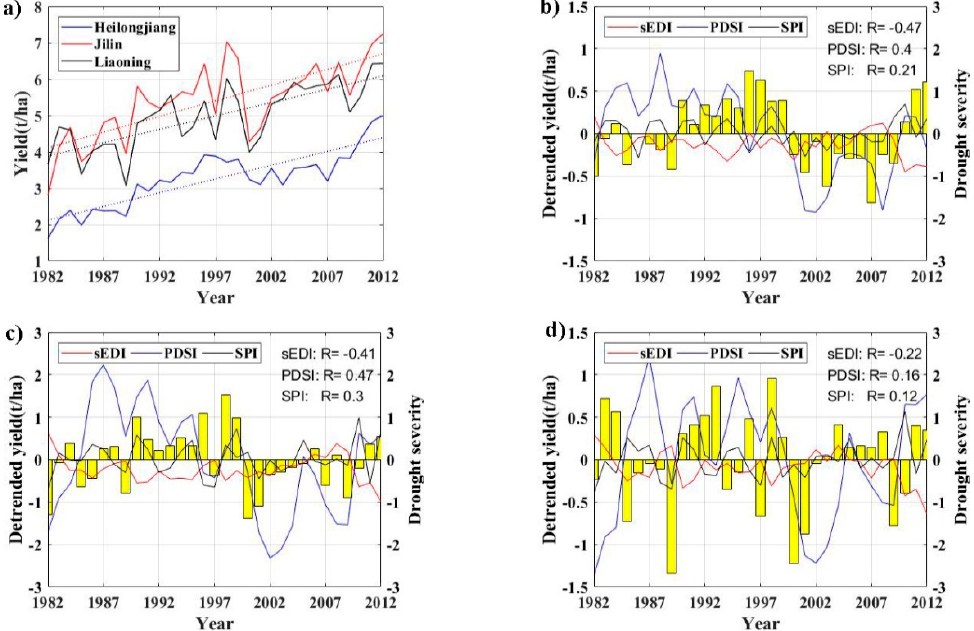
Figure 9. Time series of grain crop yields and drought indices at province level: ( a ) original value of grain crop yields for Heilongjiang, Jilin, and Liaoning; time series of detrended crop yields and drought indices for ( b ) Heilongjiang; ( c ) Jilin; ( d ) Liaoning.